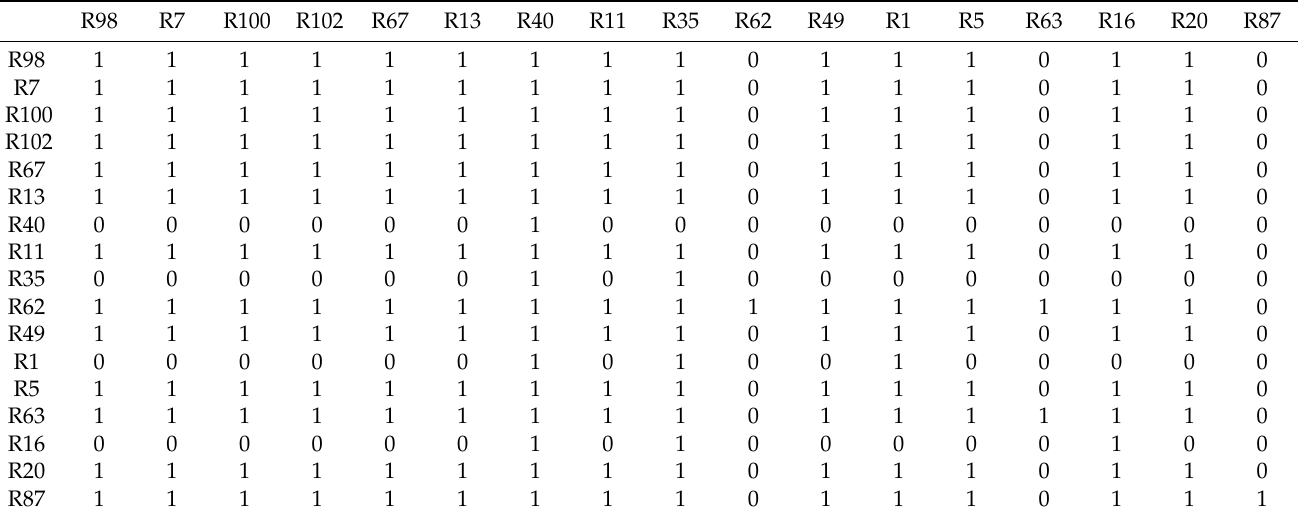
Table 5. Final reachability matrix.